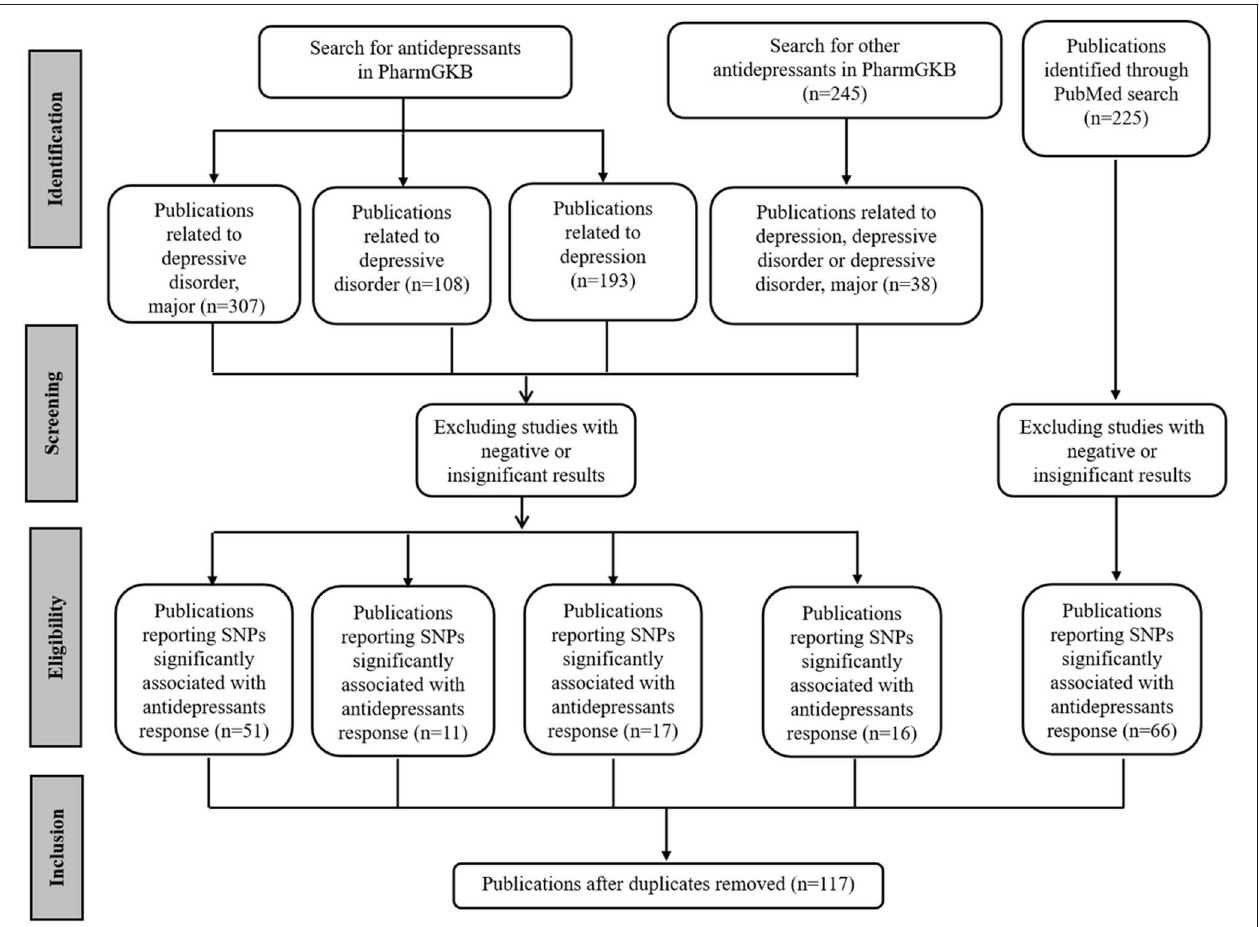
FIGURE 1 | PRISMA flow diagram illustrating search strategy and studies included in the analysis. PRISMA, Preferred Reporting Items for Systematic Reviews and Meta-Analyses (http://www.prisma-statement.org/).